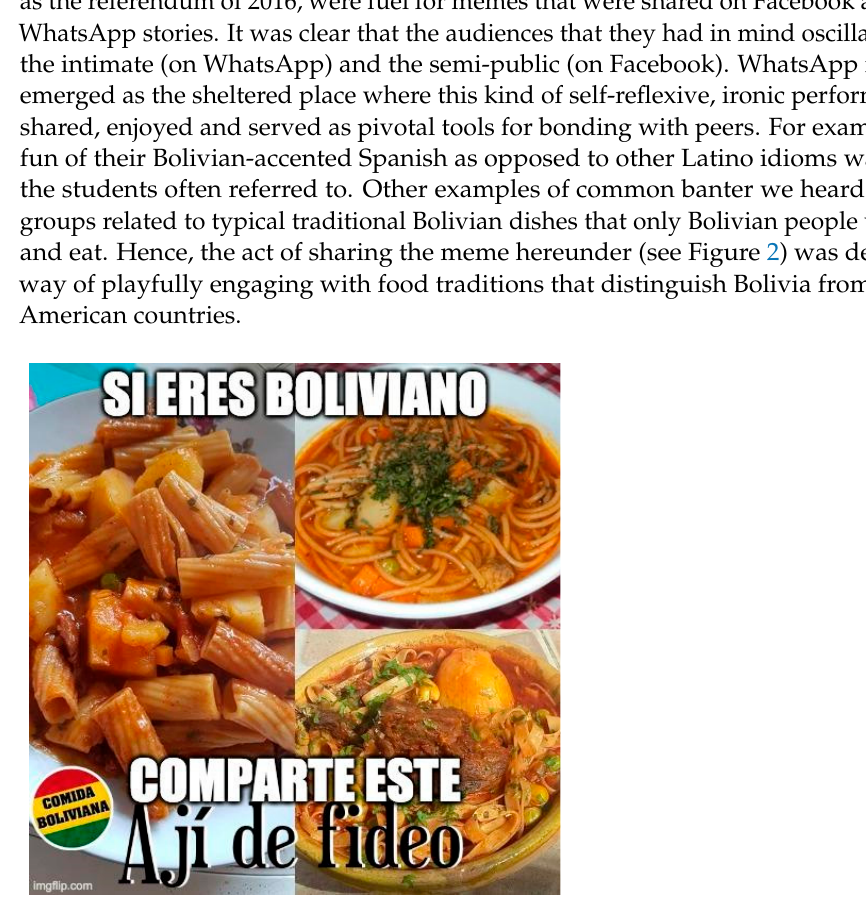
Figure 2. Share this ají de fideo